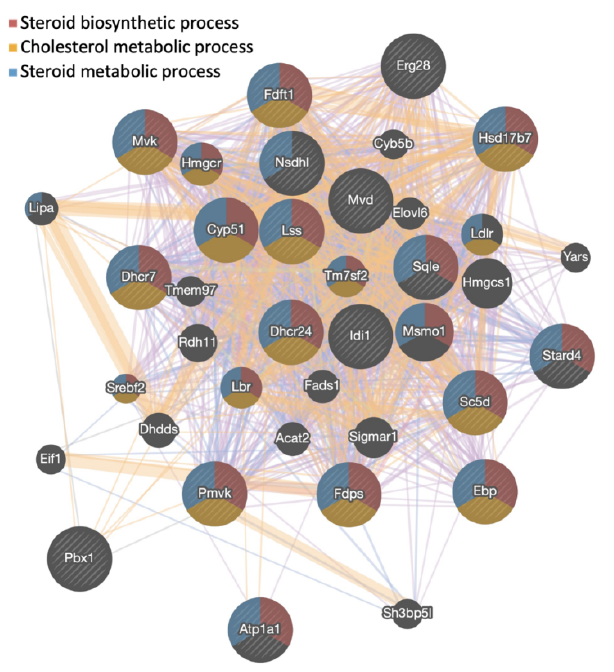
Figure 4. Network analysis of genes being upregulated by gigantol in MA-10 Leydig cells using the GeneMania function prediction tool.